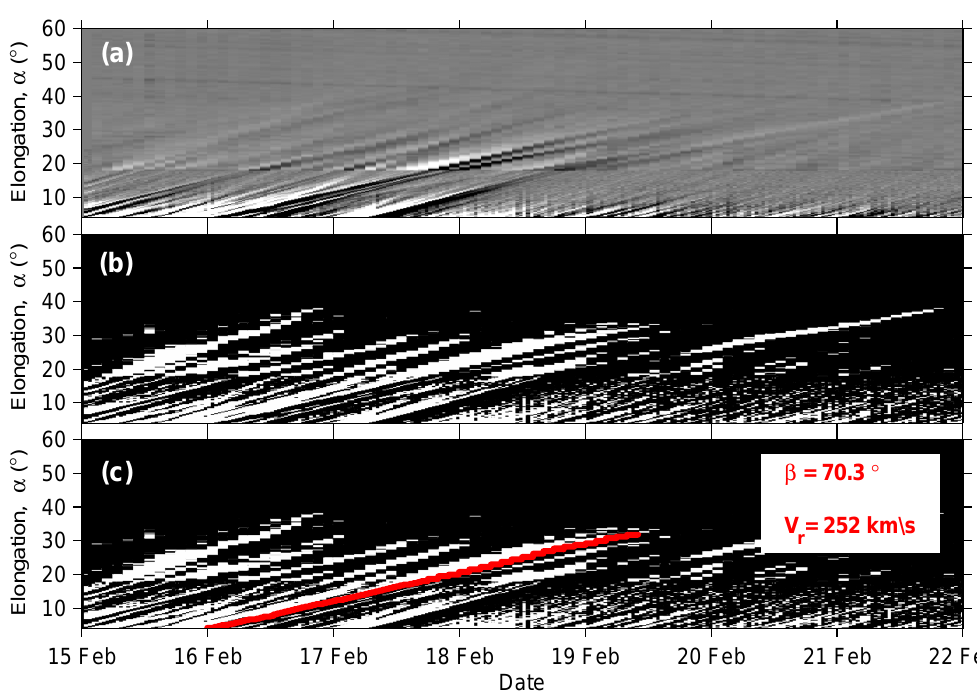
Fig. 3. (a) An elongation-time map constructed from running difference images along the equatorial line, PA=90 ◦ . (b) The elongation-time map converted to a binary black and white image to emphasise the tracks. (c) Same as b except that the additional red line is the best fit boundary of the CME. The two optimised variables from Eq. (1), longitude ( β) and radial velocity ( V r ) , are